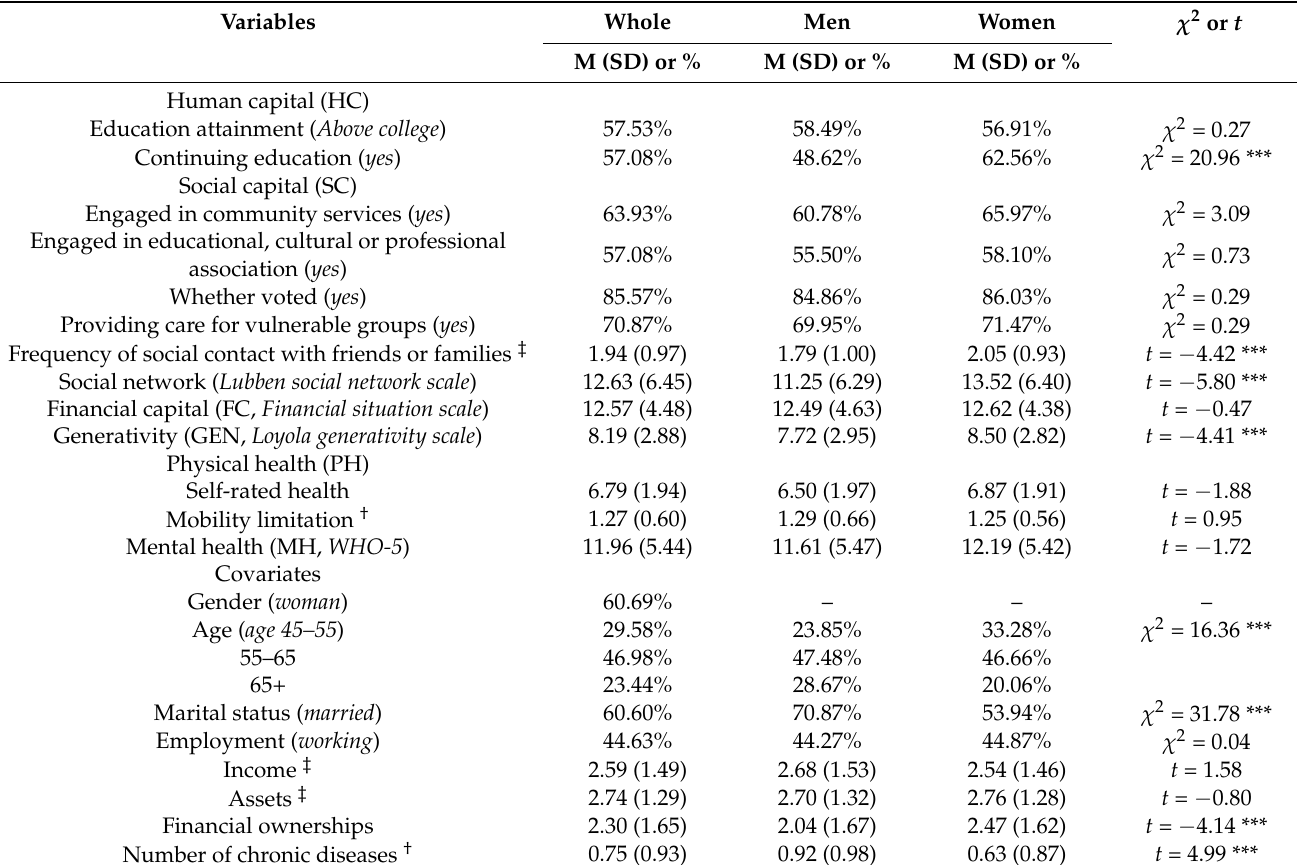
Table 1. Sample characteristics and bivariate analyses by